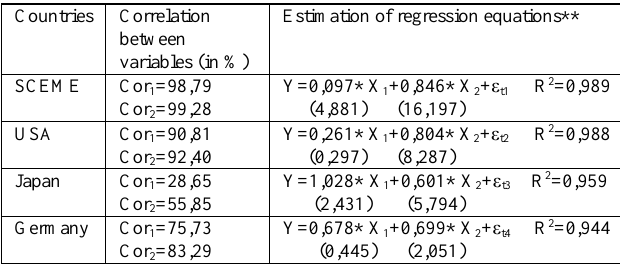
Figure 1. Rate of Real Gross Domestic Product (GDP)